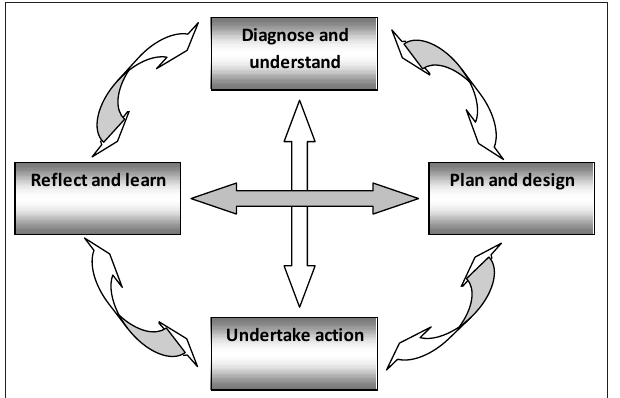
FIGURE 6: A typical action learning